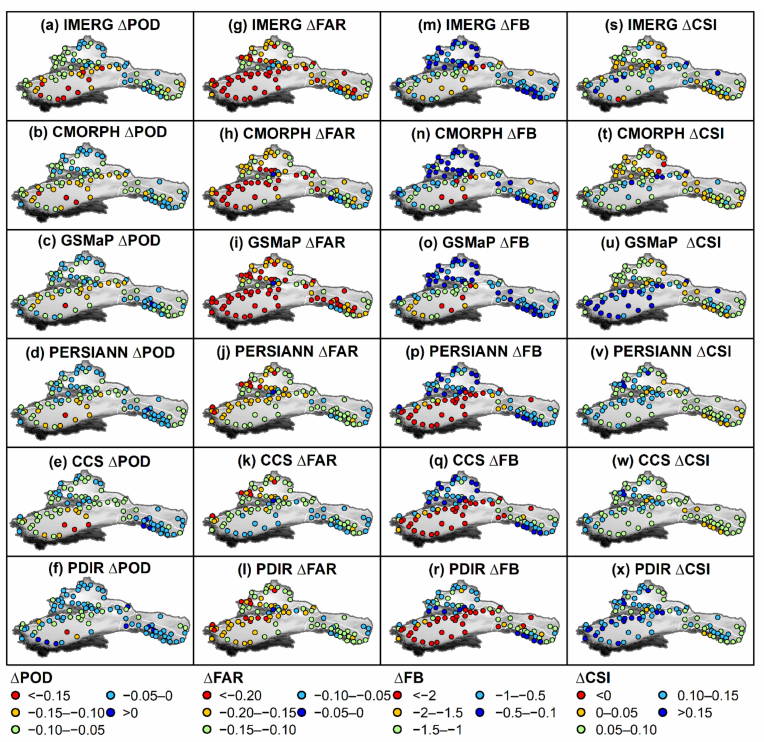
Figure 4. Spatial patterns of the changes of categorical metrics for six SPPs. The ( a – f ), ( g – l ), ( m – r ), and ( s – x ) display the ∆ POD, ∆ FAR, ∆ FB, and ∆ CSI for six SPPs,